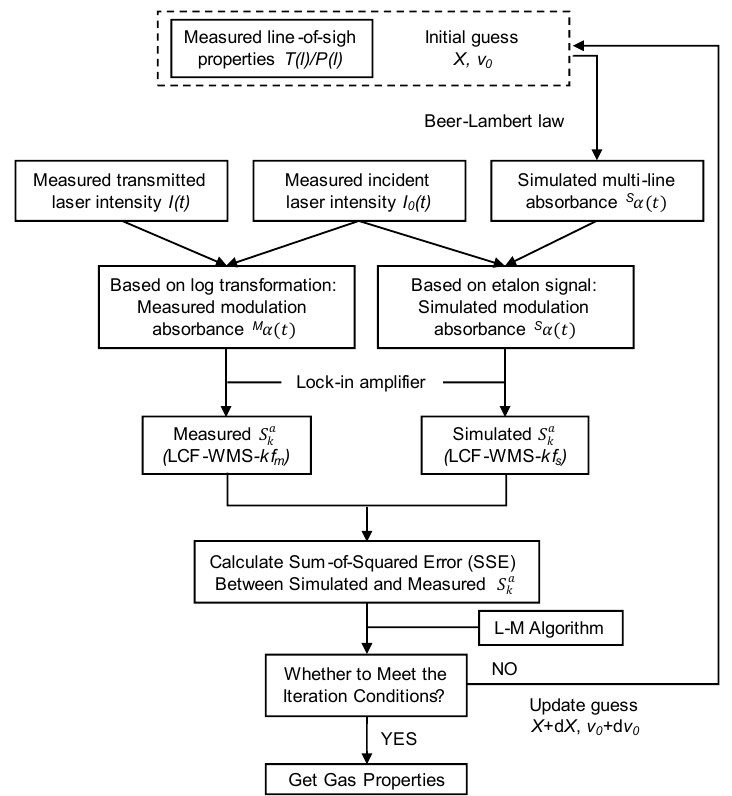
Figure 7. Algorithm for iterative fitting by comparing simulated and measured harmonic signals.